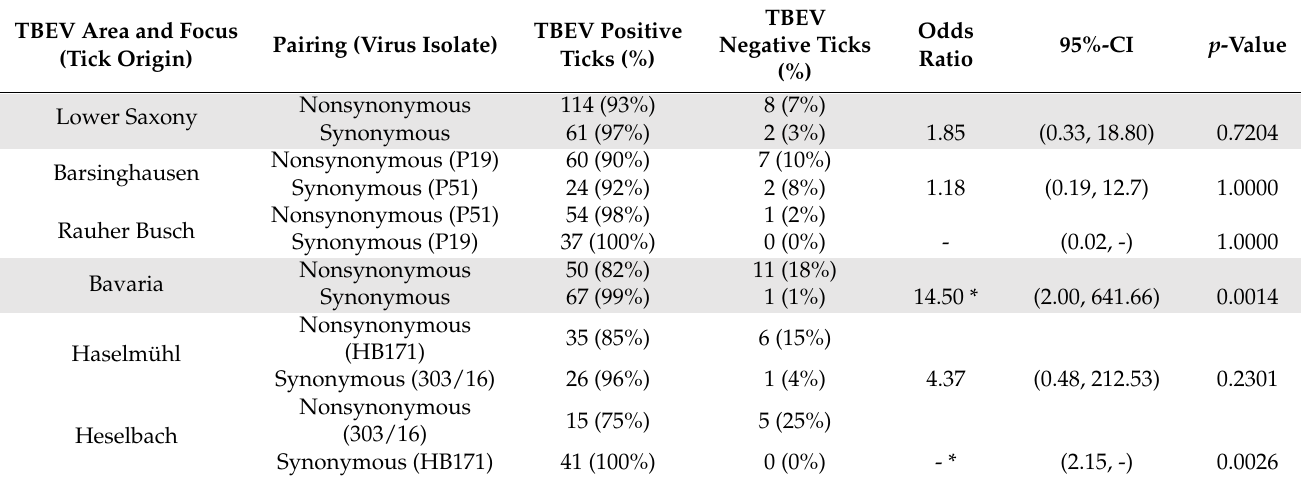
The lines for the two Federal states are marked by grey shading; the lines showing data from the TBEV-foci within those federal states are left white. An * asterisk marks all statistically significant results.